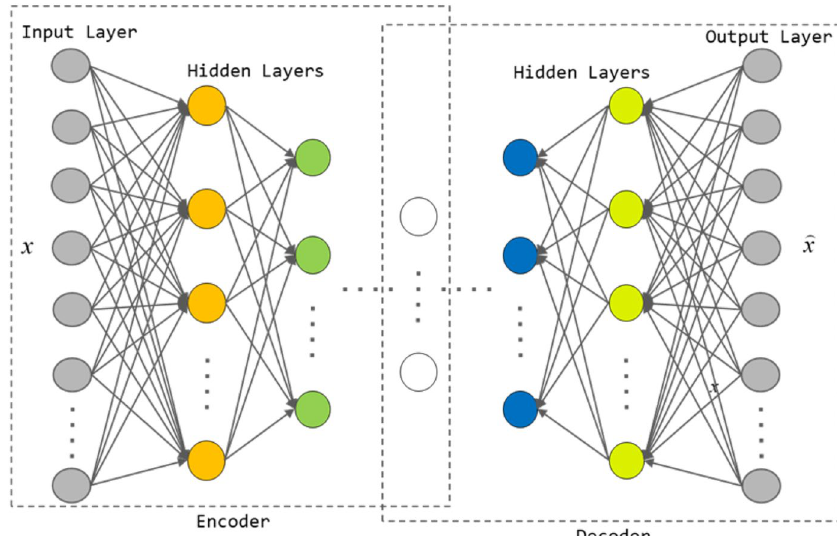
Figure 1. Hierarchical framework of SAE.